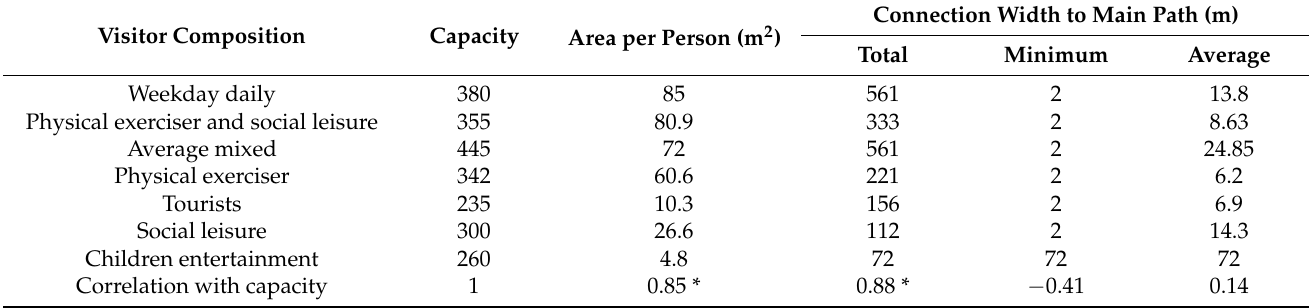
Table 5. Capacity of different visitor composition and correlation with site